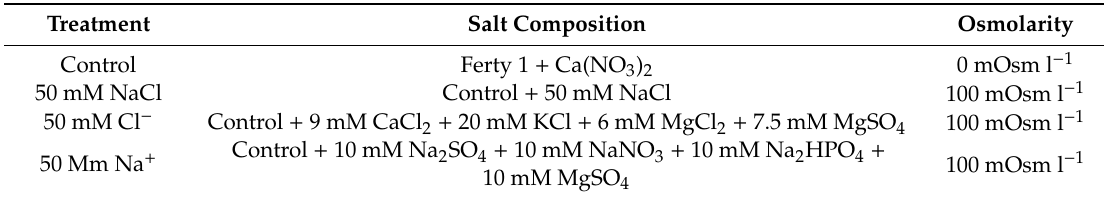
Table 1. Salt compositions of experiment